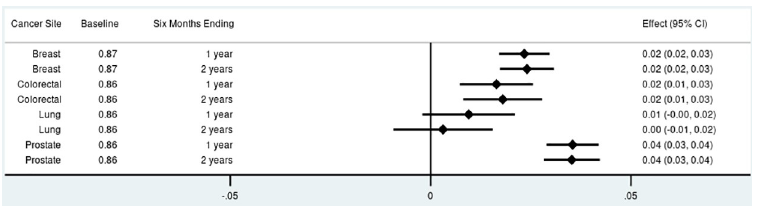
Fig 3. Total effect of cancer on proportion adherent (proportion of days covered > 80%) for anti-hypertensives by cancer site and phase of care. Point estimates and 95% confidence intervals.